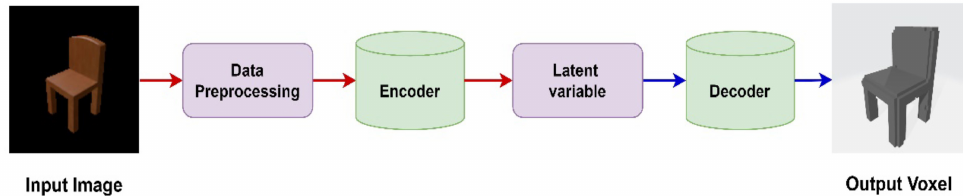
Figure 1. Process of generating the 3D voxel model for the input